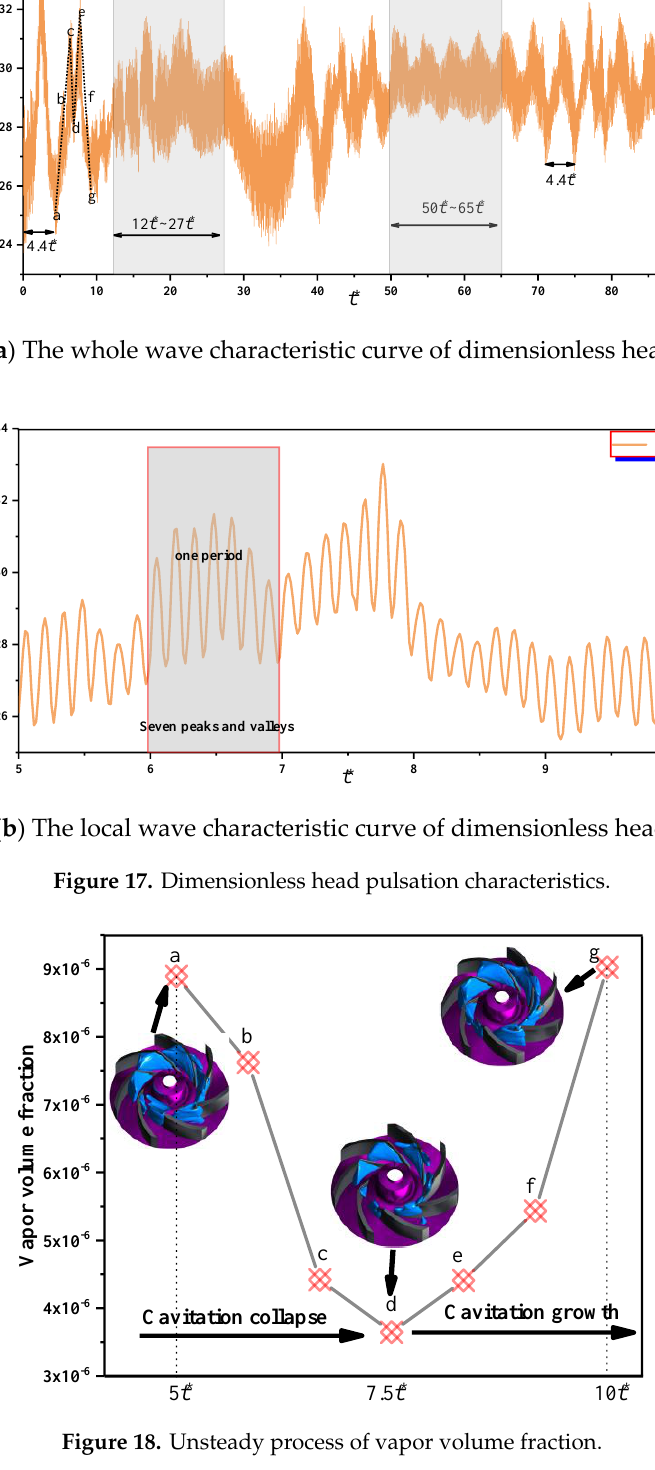
( b ) Local frequency spectrum Figure 19. Frequency domain distribution of impeller. As can be seen from the figure, the main frequency is composed of two parts under the cavitation condition of ECWP at 70 °C, including low frequency below 100 Hz and blade passing frequency ( f b = 431.69 Hz). The low frequency part is the uneven pulsation caused by the periodic initiation, development and collapse of cavitation. Through further analysis of the low-frequency components, it is found that the main low frequency consists of the two components, Where f 1 = 0.65 Hz, f 2 = 14.2 Hz. It can be seen from the above that the propagation period of large-scale wave is 4.35 t * . Therefore, the frequency of f 2 corresponds to the large-scale wave, f 2 is the cavitation frequency. As FFT cannot reflect the change process of frequency with time, wavelet transform is used to explore the unsteady process of cavitation frequency amplitude with time, shown in Figure 20. As can be seen from the figure, the cavitation frequency f 2 and blade passing frequency f b alternate into dominant frequency in the time range of 0~90 t *.The main frequency components after wavelet transform are consistent with the above, namely f b and f 2 , and the lower frequency f 1 is not captured due to the insufficient data. It can be seen from the figure that the frequency of f 2 does not change with time as the impeller rotates in the circumferential direction, and keeps a fixed value. With the impeller rotating, the main frequency which affects the head pulsation of ECWP is changing alternately. Especially in 15 t *~30 t *, with the decrease of cavitation effect, the rotor and stator